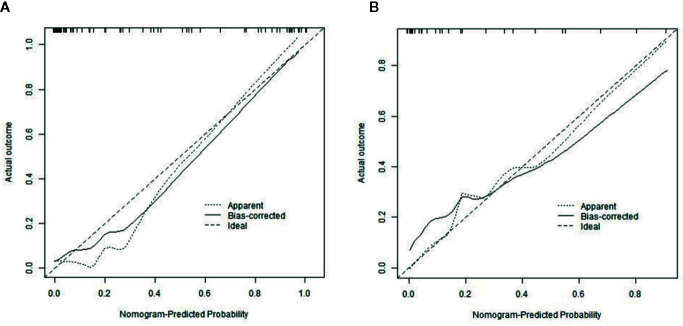
Calibration curves of radiomics nomogram in the training (A) and validation (B) cohorts. The diagonal line represents the perfect prediction of the radiomics nomogram. The black solid line represents the calibration curve of radiomics nomogram. The calibration curves are close to the diagonal line both in the training and validation cohorts, which shows that the prediction probability have good agreement with the actual probability.